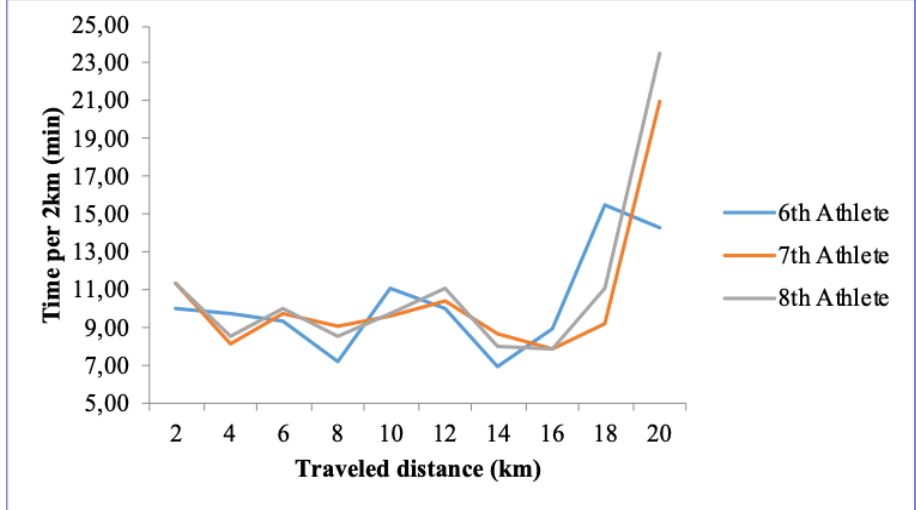
Figure 4. The individual times per 2km of the group 15-30%, of the athletes in the 20km of race walking.